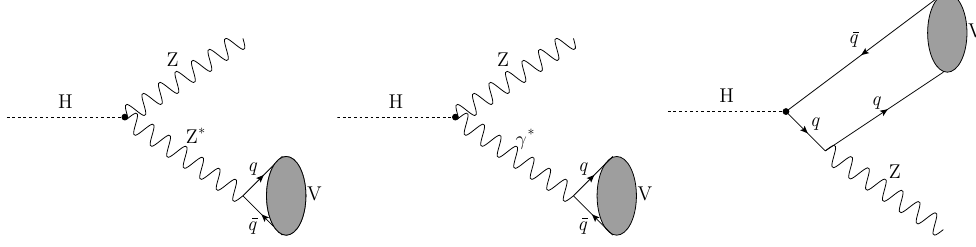
Figure 1 . Feynman diagrams of processes that contribute to the decay of a Higgs boson into a heavy vector boson and a vector meson. The grey oval shape represents the meson. The two indirect processes (left and middle), where the meson originates from an off-shell Z boson or (cid:13) ∗ , contribute the most to the total branching fraction in the